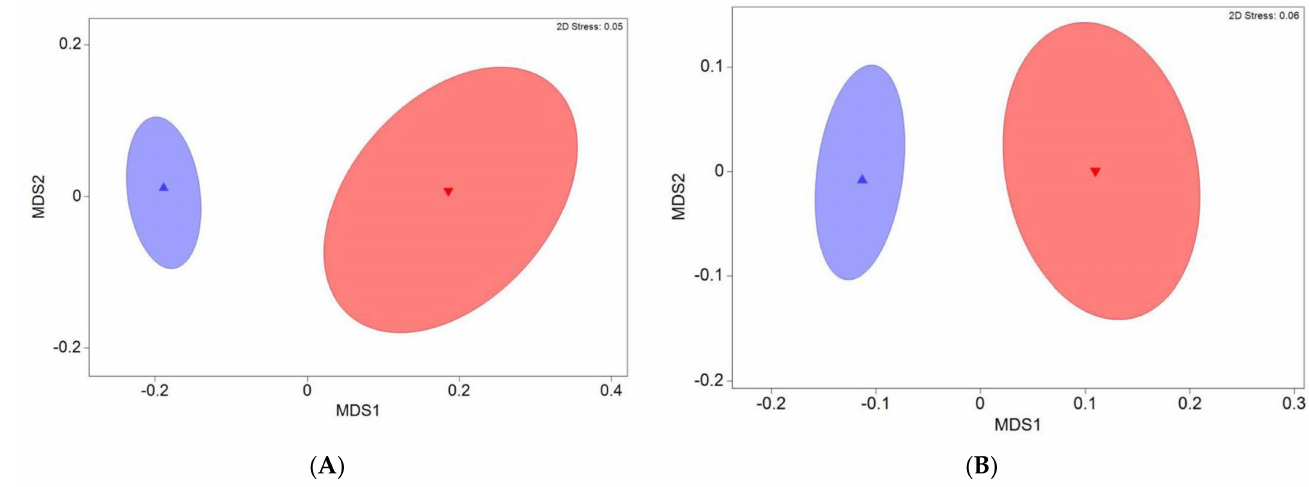
Figure 2. Metric Multidimensional Scaling (MDS) plots and bootstrap averages of biochemical patterns. Samples of healthy patients (H, blue) and CIN patients (CIN, red). ( A ) Cytoplasmic analysis and ( B ) nuclear analysis. CIN = cervical lesion. Dots represent centroids and areas 95% confidence